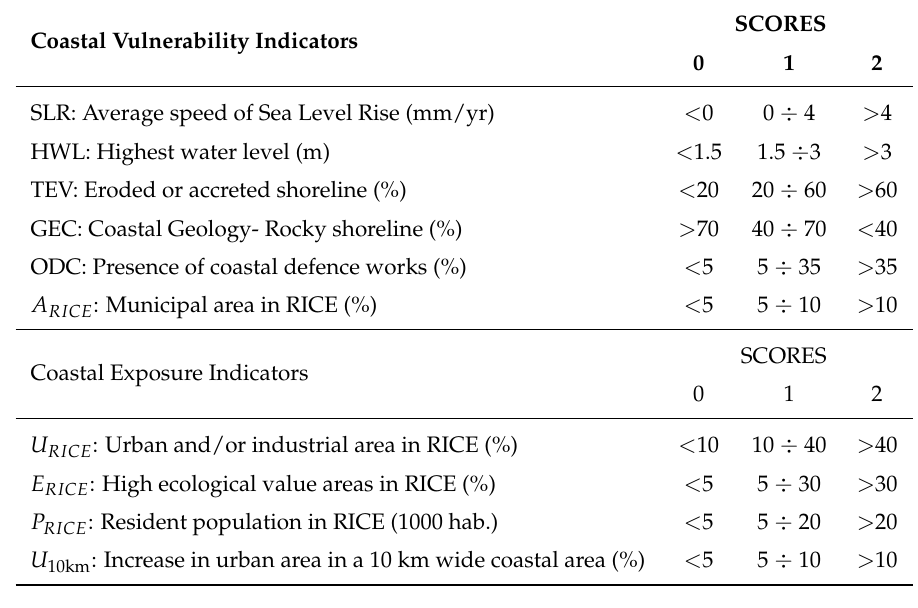
Table 1. Ranking scores of CVI and CEI used in EUrosion